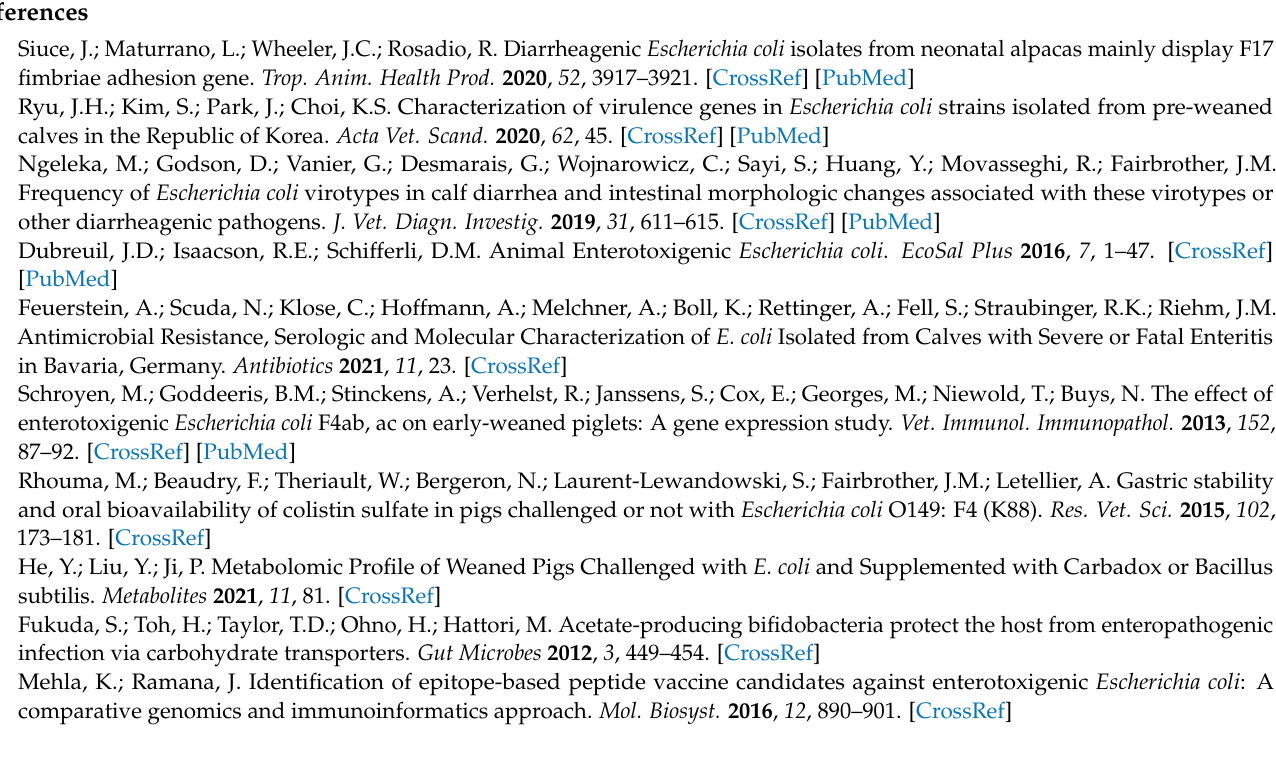
samples. Table S2: Transcriptomic data of AN and SE samples. Table S3: Detailed identified metabolites of AN and SE samples. Table S4: Annotation results of the identified metabolites. Table S5: Differential analyses results of the identified metabolites. Table S6: Parameters training and detailed results of Random Forest. Table S7: PCCs between the variables selected by Random Forest. Table S8: Edge betweenness centrality of each node in the interaction